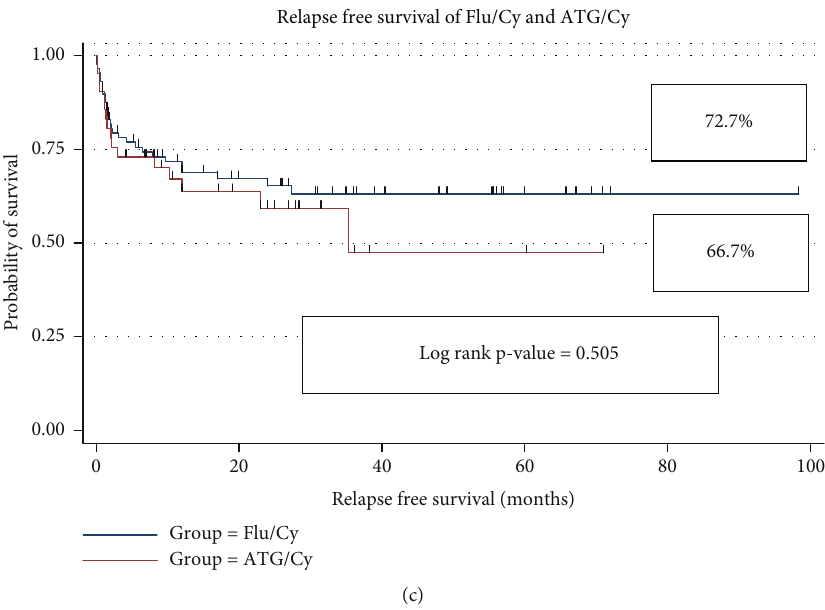
Figure 2: OS, GFS, and RFS as per conditioning regimen in Flu/Cy and ATG/Cy groups. Table 3: Univariate analysis of in fl uenced factors for overall survival (OS), GvHD-free survival (GFS), and relapse-free survival (RFS).